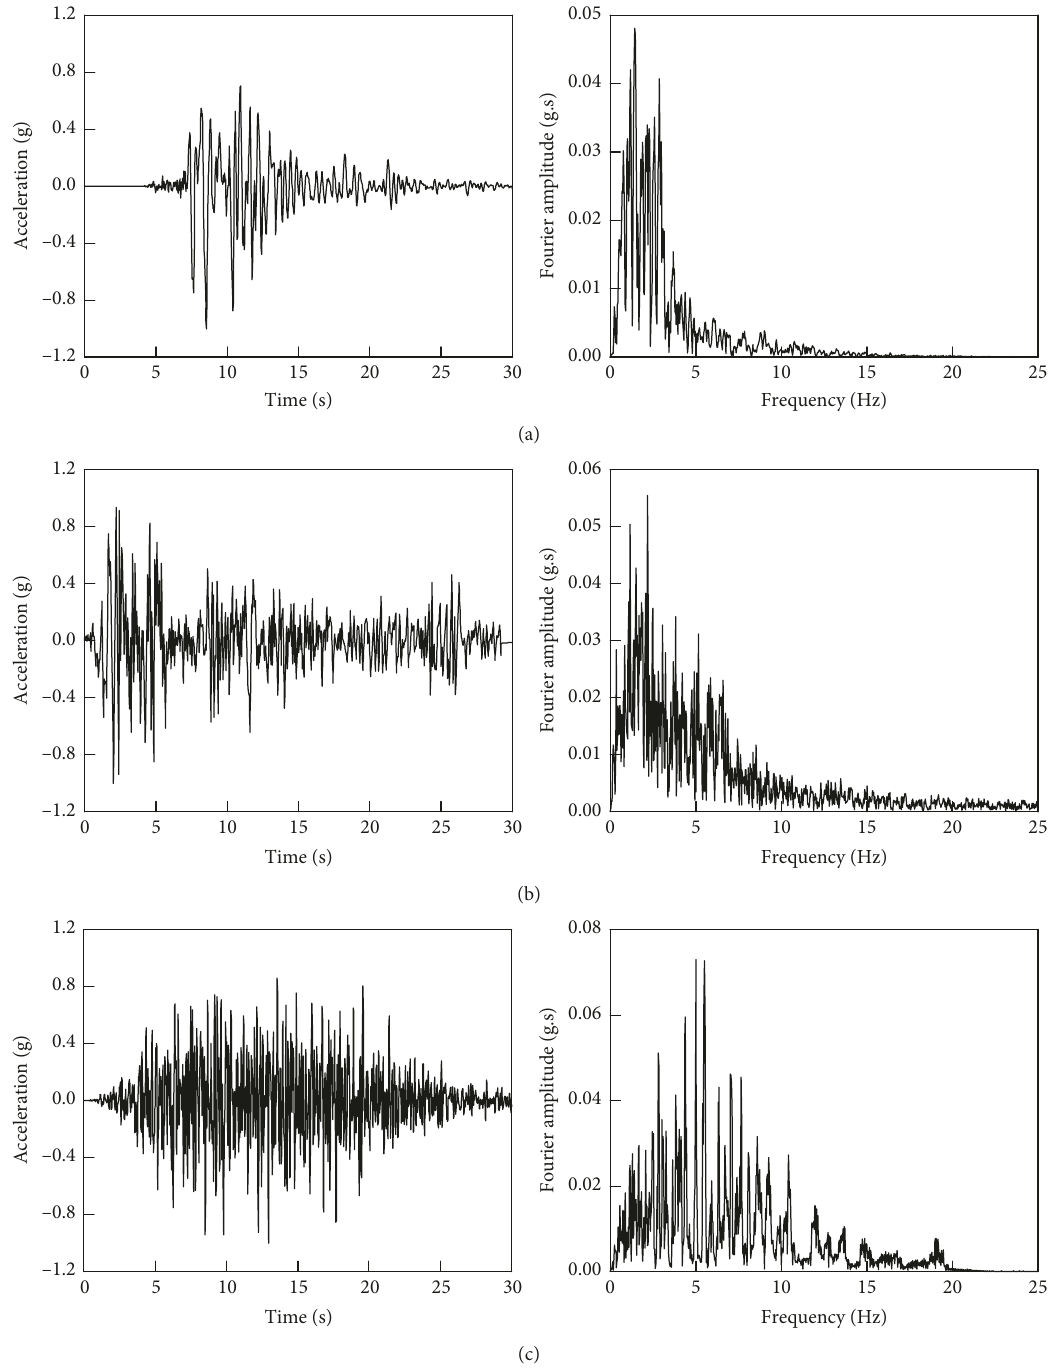
Figure 10: Ground motion acceleration-time histories and Fourier spectra input on the shaking table. (a) Kobe record. (b) El Centro record. (c) Guangzhou artificial